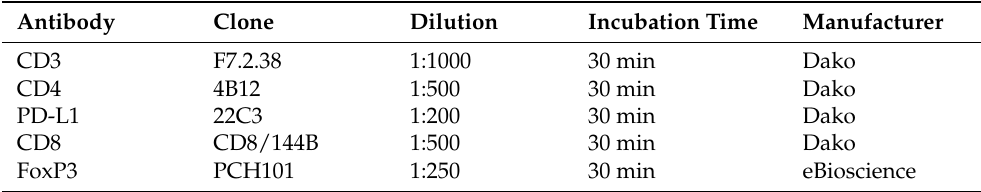
Table 2. List of monoclonal